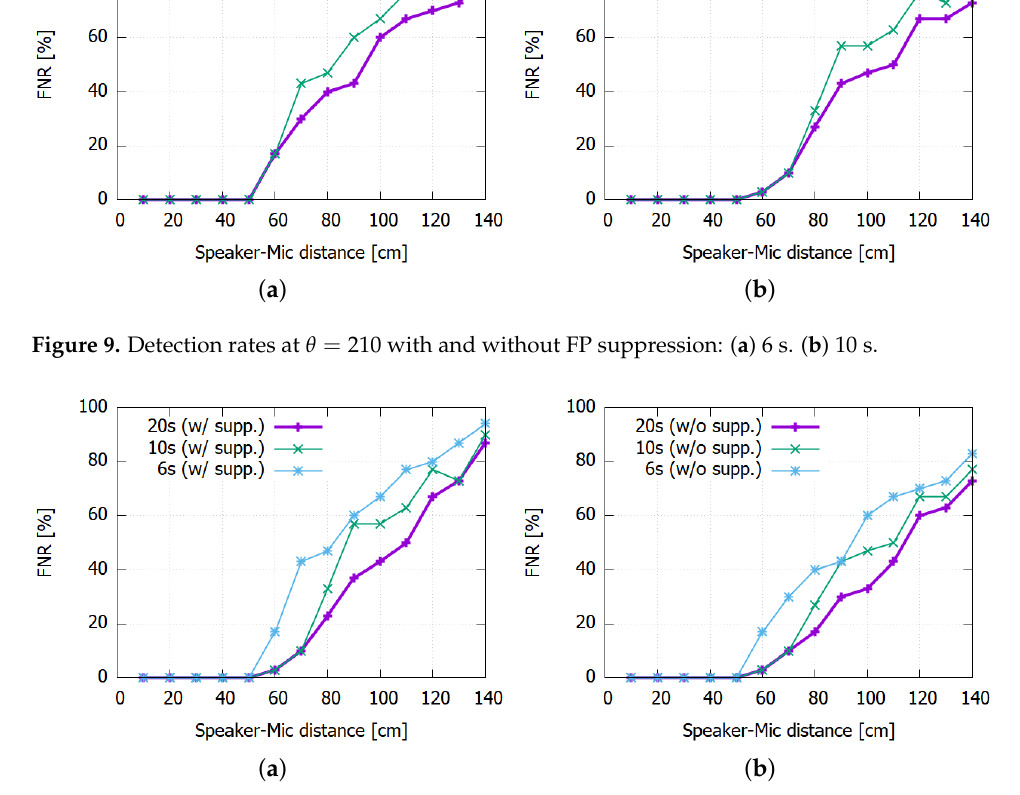
Figure 10. Impact of extending L win to 20 s: ( a ) With suppression. ( b ) Without